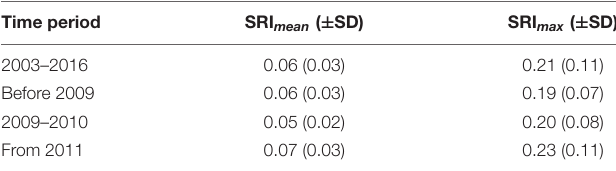
TABLE 1 | Temporal variations of the average mean and maximum association indices (Simple Ratio Index SRI).